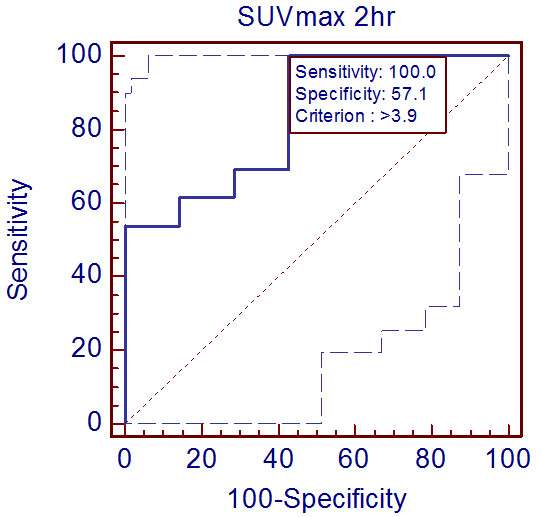
Receiver operating curve analysis of standardized uptake value (SUV)max2. The sensitivity and specificity were calculated when the SUVmax2 cutoff value was set at 3.9.